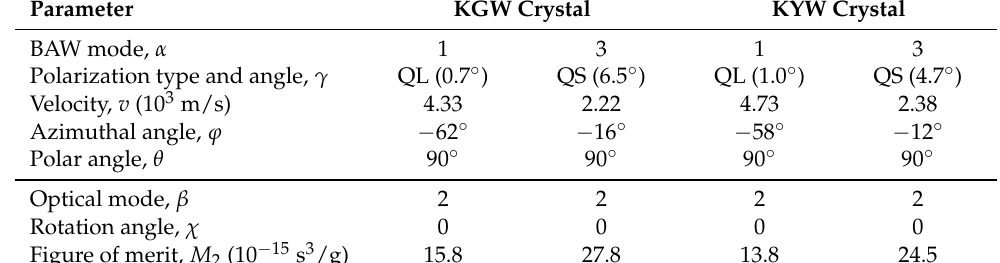
Figure of merit, M 2 (10 − 15 s 3 /g)